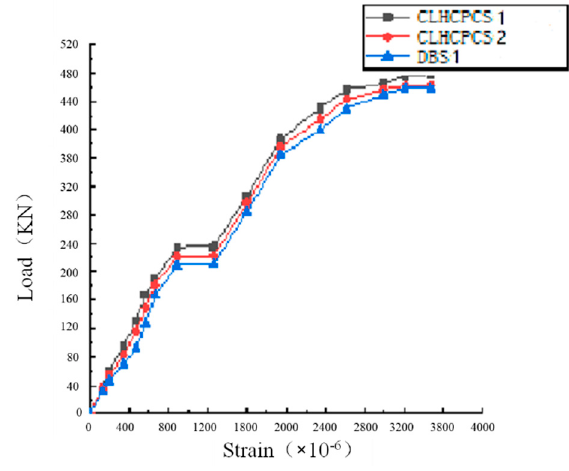
Figure 22. Load − strain curve diagram of rebar joints of the composite slab.